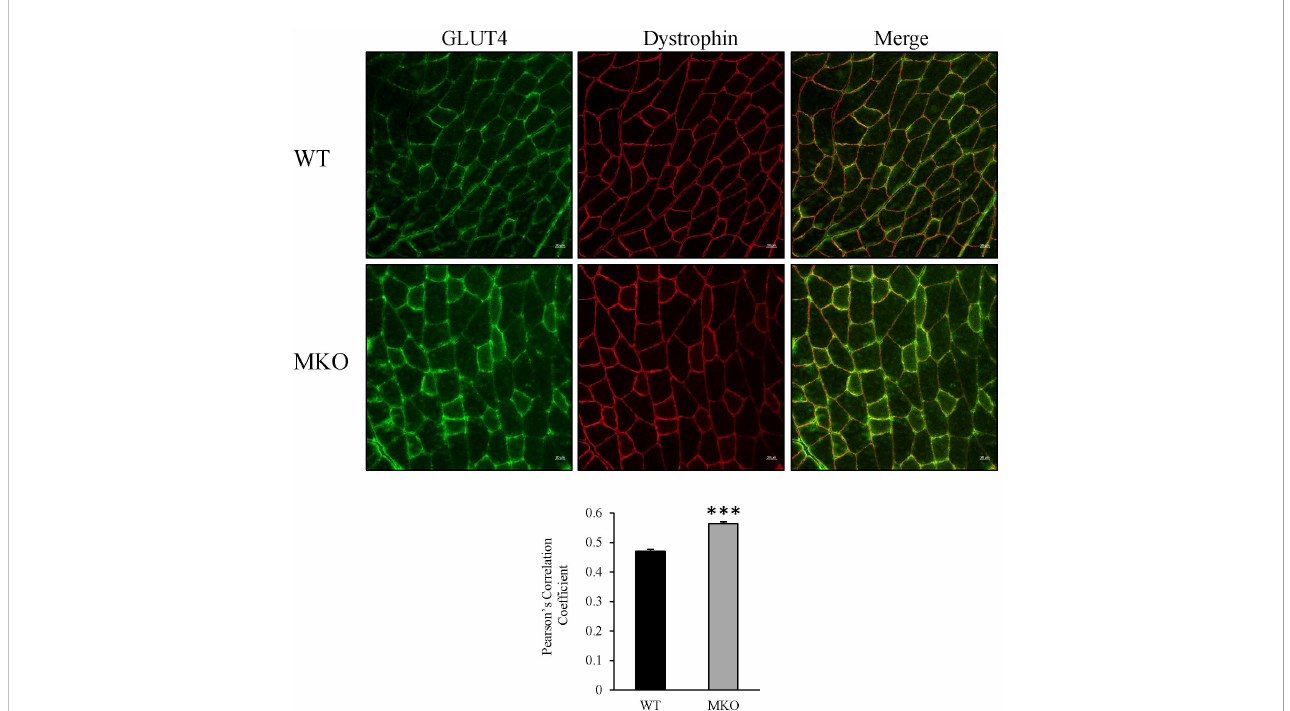
FIGURE 8 GLUT4 localization to the plasma membrane was increased in Arid5b MKO GC. Coimuno fl uorescence analysis for GLUT4 (green) and dystrophin (red) was carried out in GC tissue sections. Representative confocal images are shown. Scale bars = 20µm. Merged images show increased colocalization of